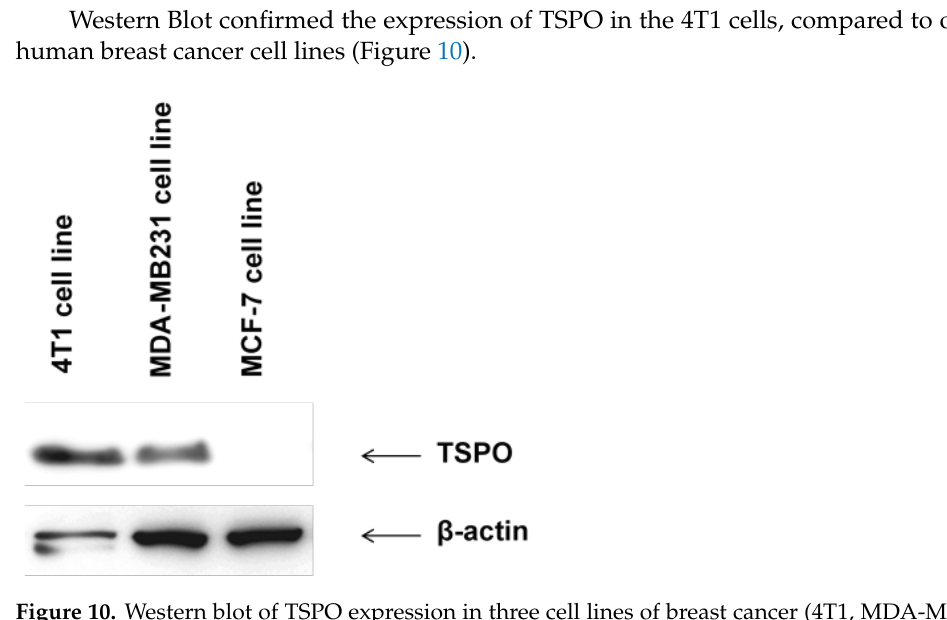
Figure 9. Images of immunofluorescence reactions in tumor tissue with Hoechst dye (Nucleus) and OXPHOS (oxidative phosphorylation), and fusion of the two of them. The dashed line divides the tissue sections into an upper (edge) and lower (center) region.